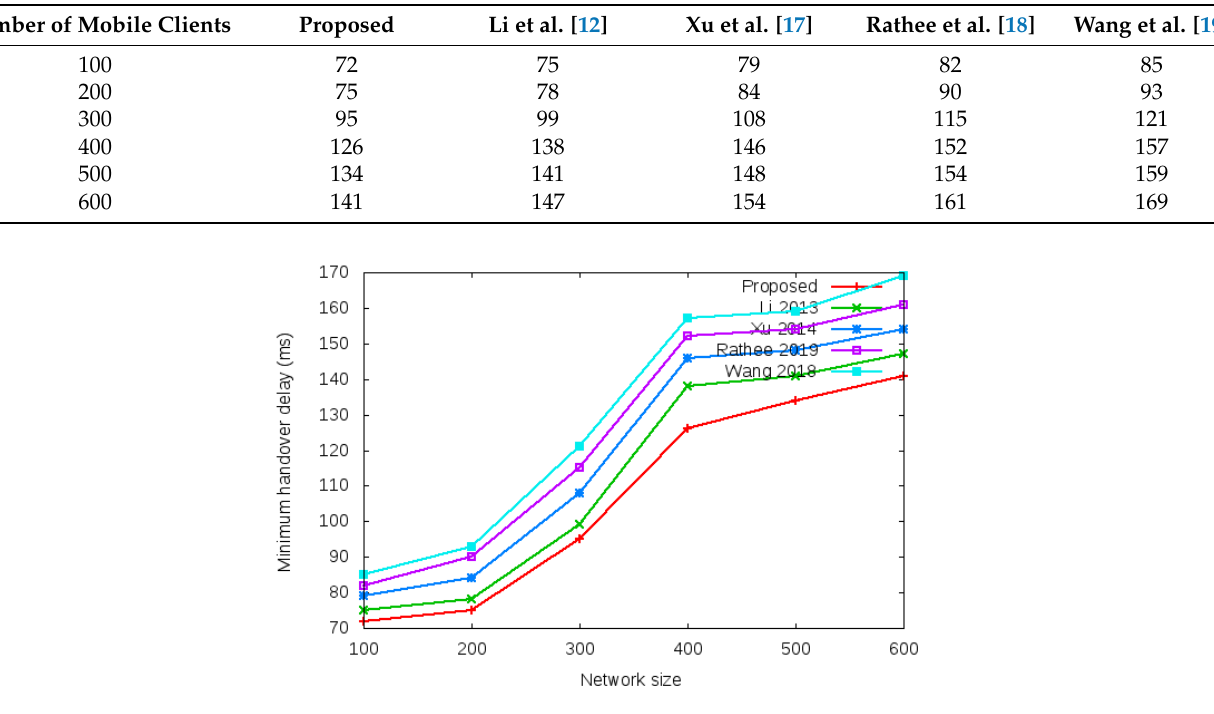
Figure 14. Minimum handover authentication delay.